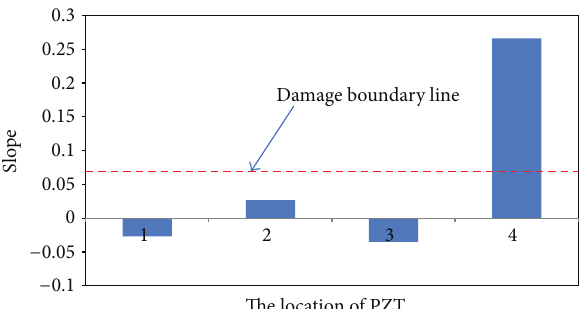
Figure 13: A damage metric chart of RMSD’s slope for damage on joint